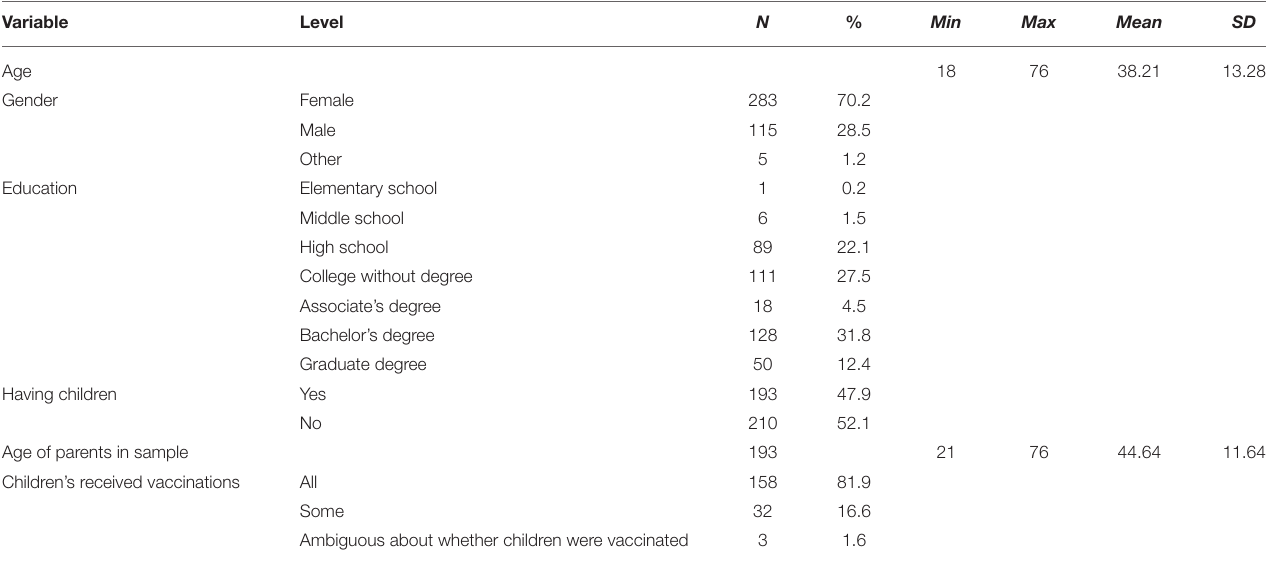
TABLE 2 | Participant characteristics in experiment